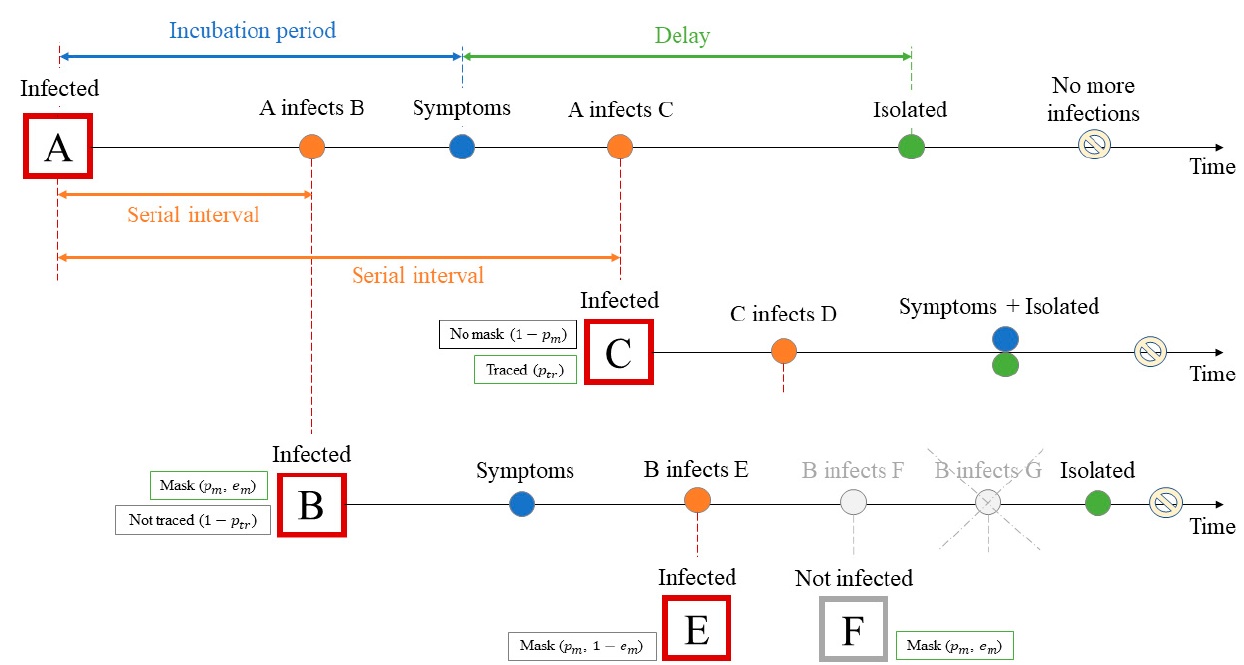
Figure 1. Scenario example for the simulated branching process. Initially, there is one infected person A who does not wear a mask and who was infected at time t = 0. A infected B before the symptoms onset, who then infects C after symptom onset and is isolated with a certain delay. In its turn, the new case C infects several people before it is isolated. However, since the case C is traced, its time of isolation comes earlier than it would have been without tracing (for this example, the isolation time coincides with the appearance of symptoms). Case B, unlike case C, is not traced, but the person wears a mask, which reduces the number of secondary cases that it can produce: instead of three new cases, B infects only two (E and F cases). In this example, we suppose the mask can be used for source control and for the protection of healthy persons from infection with some efficiency e m . Therefore, the person F does not get infected because of the mask, while for person E, the mask does not work, and E becomes infected. Thus, case B, instead of the possible three potential new cases, produces only one new case.